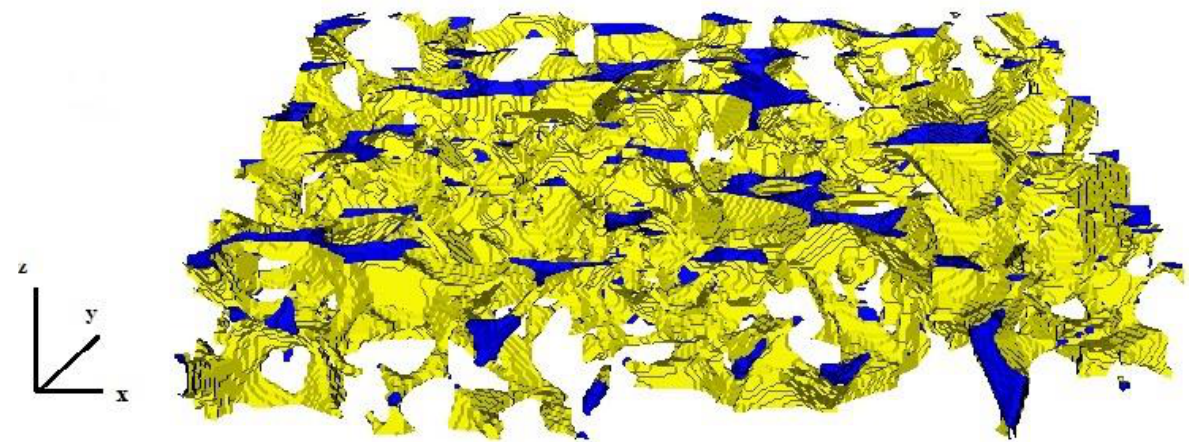
Figure 3. The view from side of the stereolithography surfaces of the pore space of an S1-subsection, ranging between (0-434.15) micrometers in the each